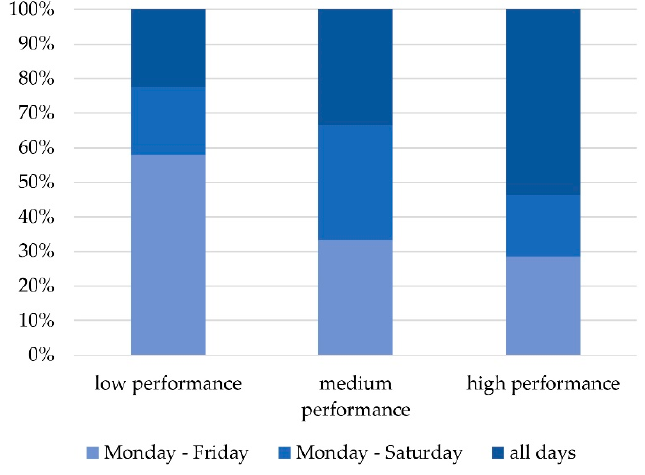
Figure 15. Opening days by performance category.